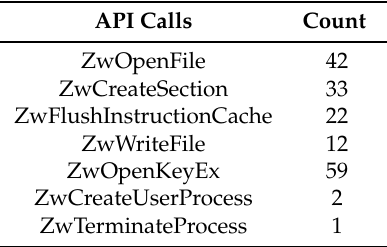
Table 1. List of strings extracted from analysis